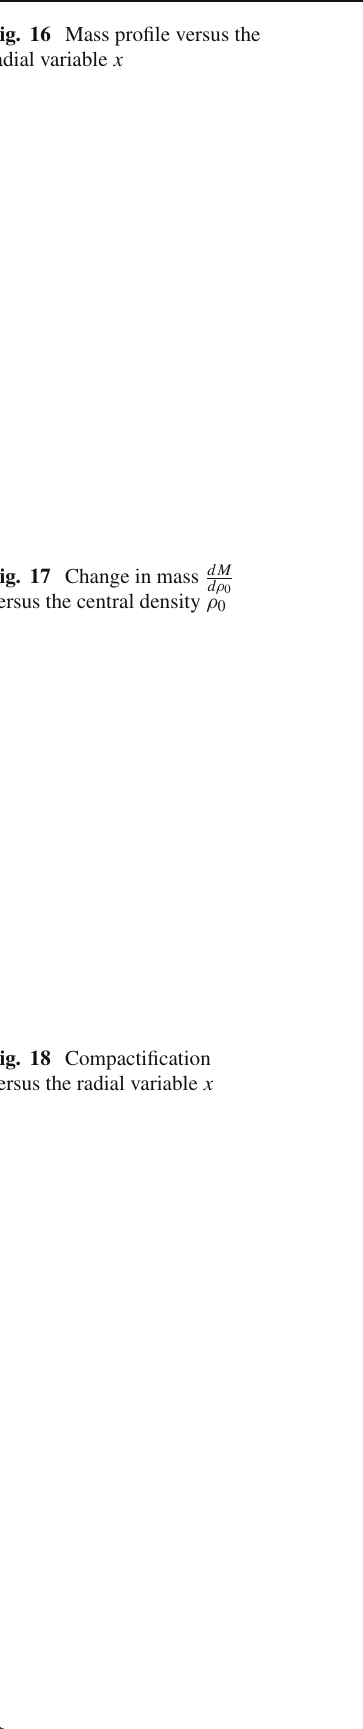
Fig. 18 Compactification versus the radial variable